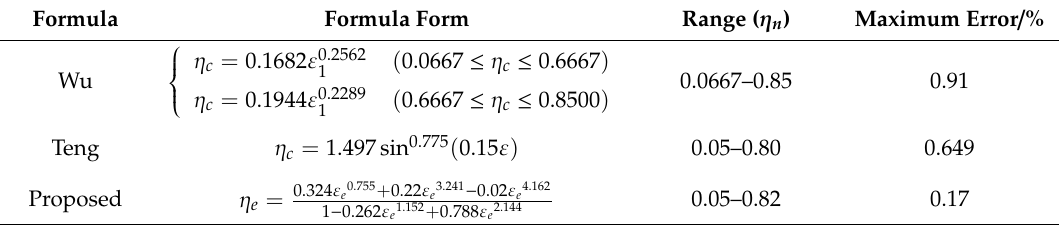
Table 4. The comparison of different formulas for the critical depth of an egg-shaped section.